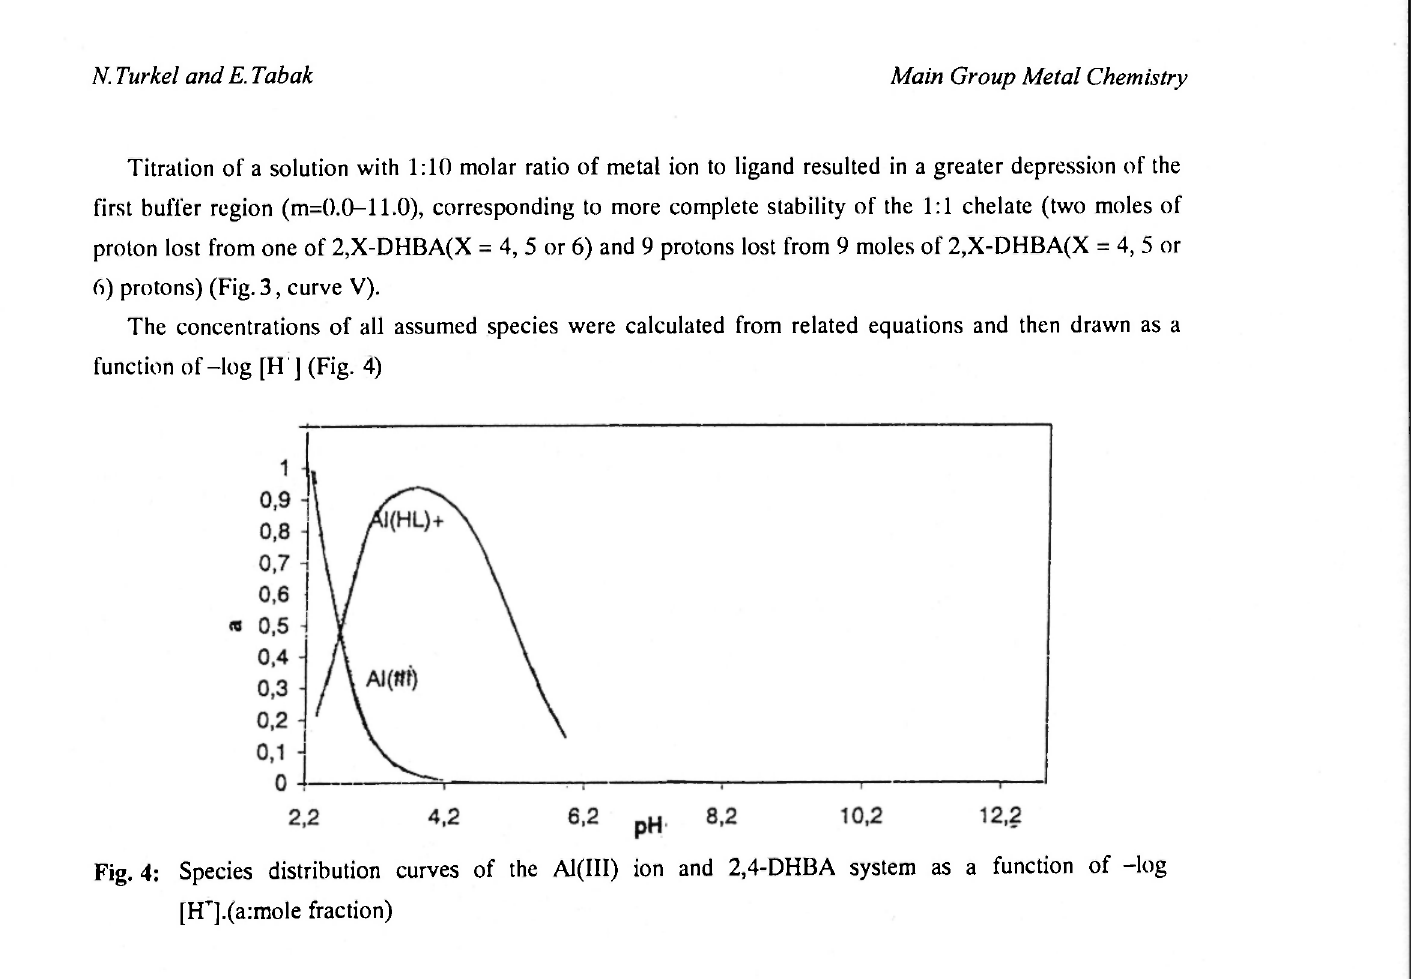
Fig. 4: Species distribution curves of the Al(III) ion and 2,4-DHBA system as a function of -log [FT].(a:mole